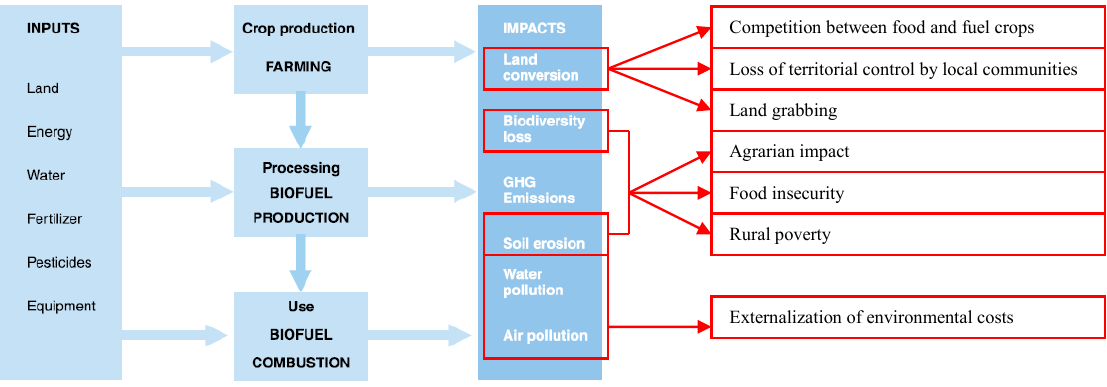
Fig. 3 – The organisations’ sector in which the respondent worked (n=197). Source: EC, 2011, p. 14